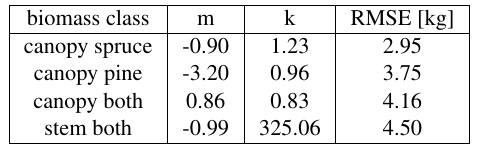
Table 2. Tree biomass model parameters and RMSE for the model fit, Equations